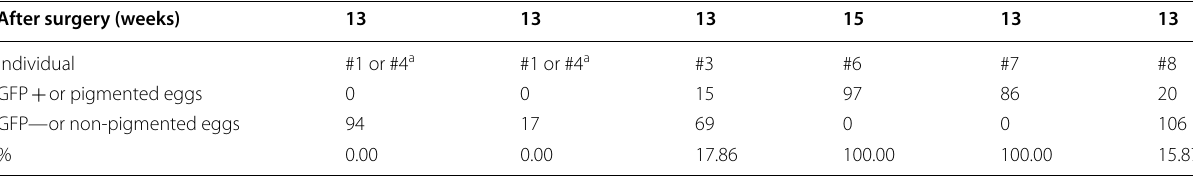
Table 4 Results of the mating analysis at 13 weeks or more after surgery: surrogate father of d‑rR strain allografted with actb ‑GFP strain or wild‑derived strain testis